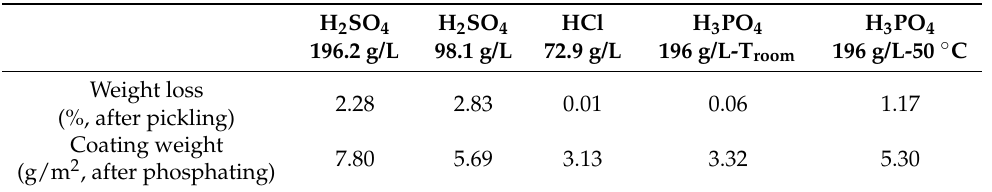
Table 3. Weight loss (%) after the pickling with the pickling acids and weights (g/m 2 ) of the phosphate coatings developed